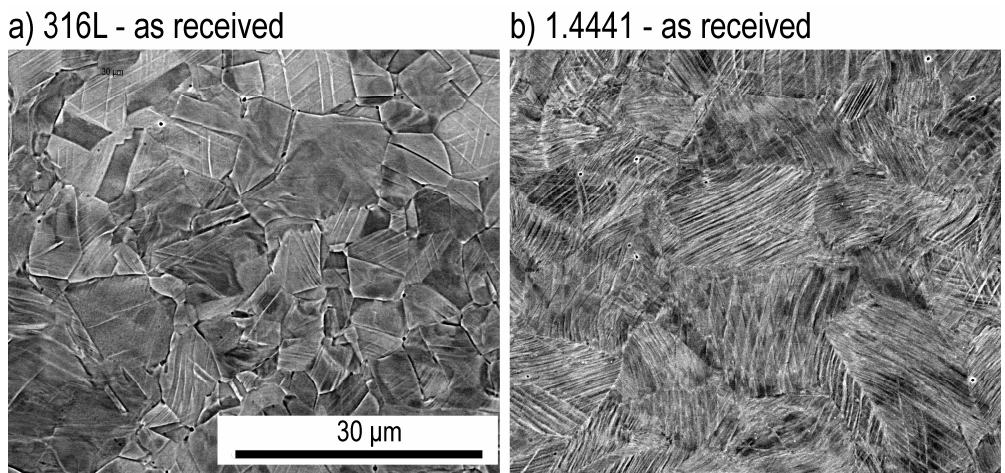
Figure 5. Microscopy using backscattered electrons reveals the microstructures in the as-received state of ( a ) 316L and ( b ) 1.4441.